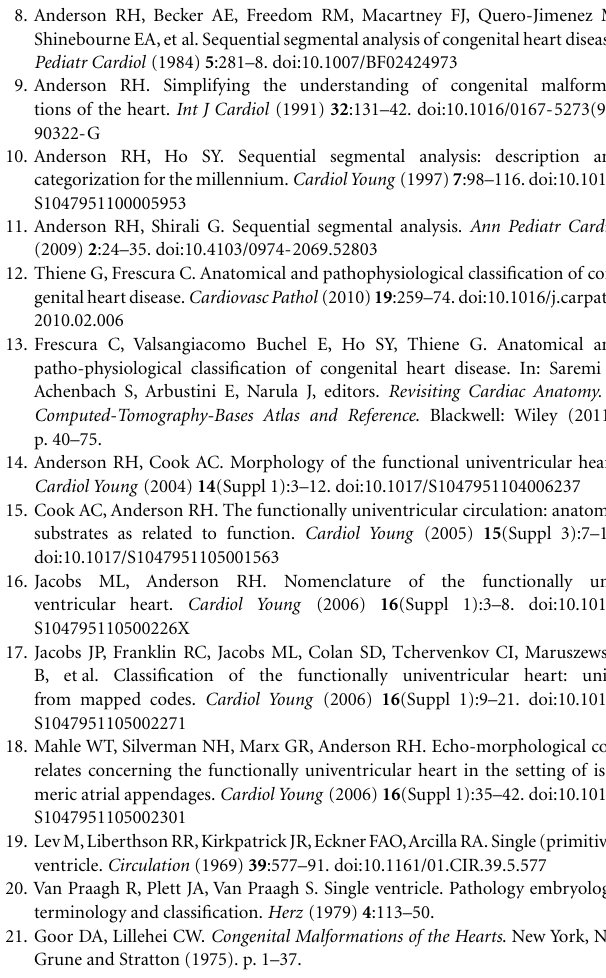
FIGURE 15 |Aortic stenosis with hypoplastic left heart . (A) View from the left ventricular chambers: the left ventricle is hypoplastic with hypertrophic free wall. Note the hypoplastic mitral valve and the severe endocardial